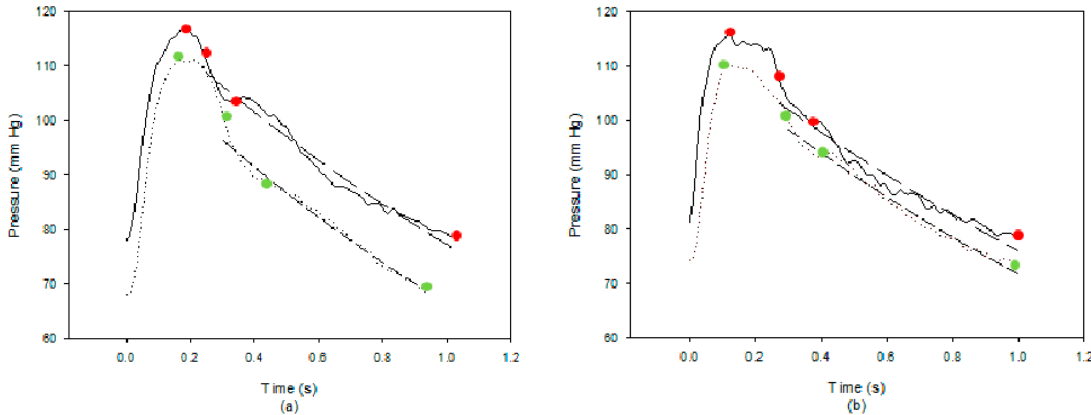
Figure 7. The blood pressure contours and curve fitting results before PLR test (solid line) and during PLR test (dot line) ( a ) for subject 17 and ( b ) for subject 16.